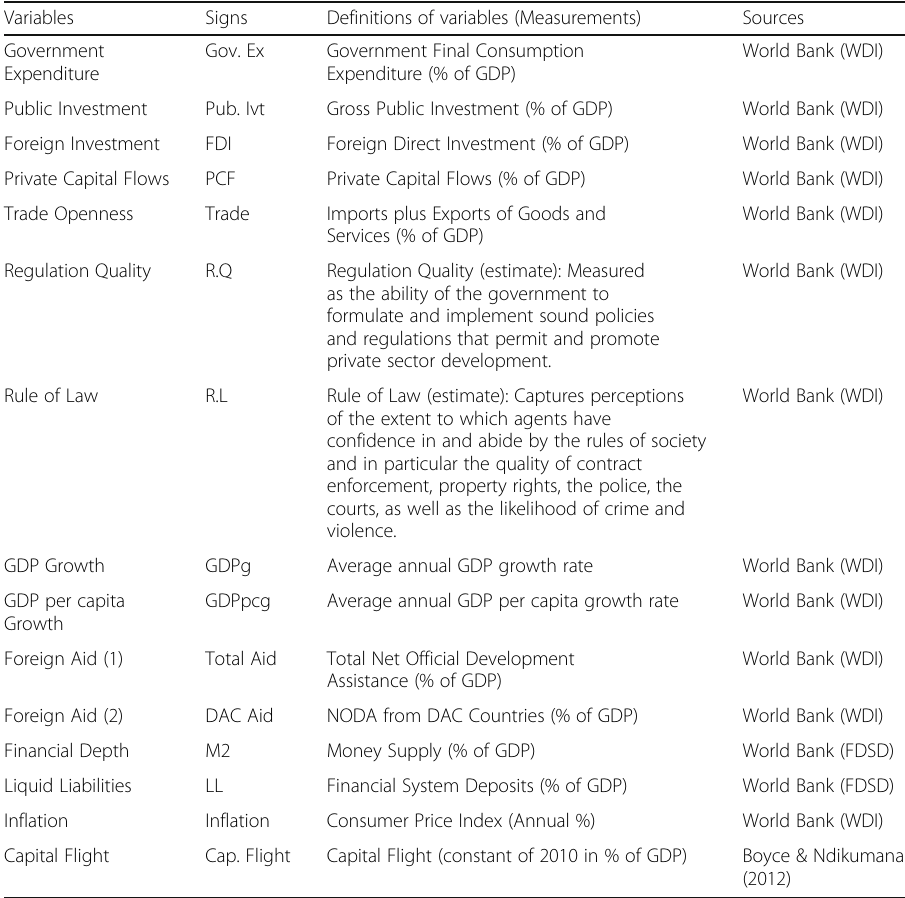
Table 7 Definitions of